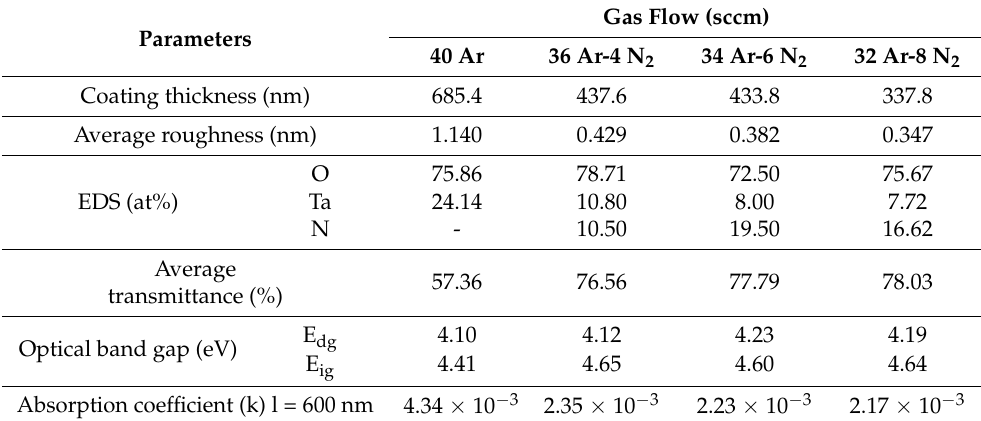
Table A1. Summary table of each parameter of the coating